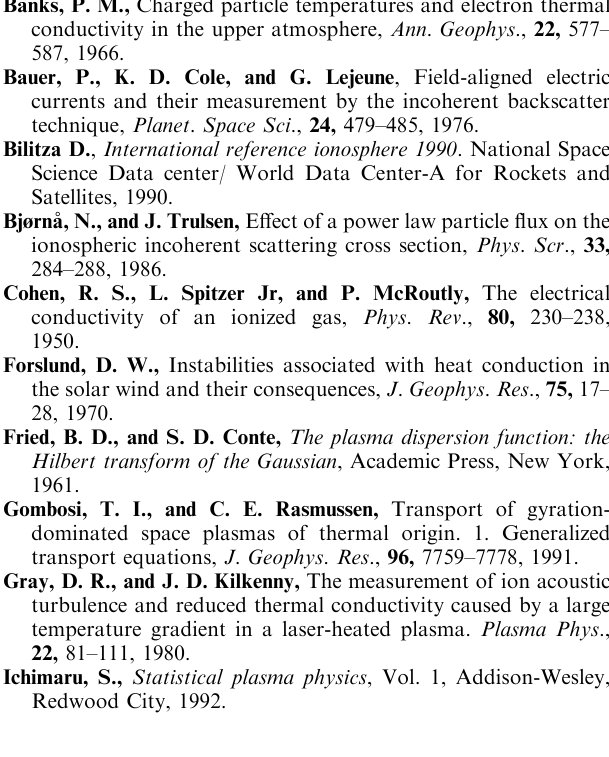
Fig. 14. In the left plates, the ratio v (cid:47) = v e where v (cid:47) is the phase velocity of the Langmuir wave for the three di(cid:128)erent radars (from top to bottom UHF, ESR and VHF). In the right plates, the integrated heat flux up to the phase velocity v